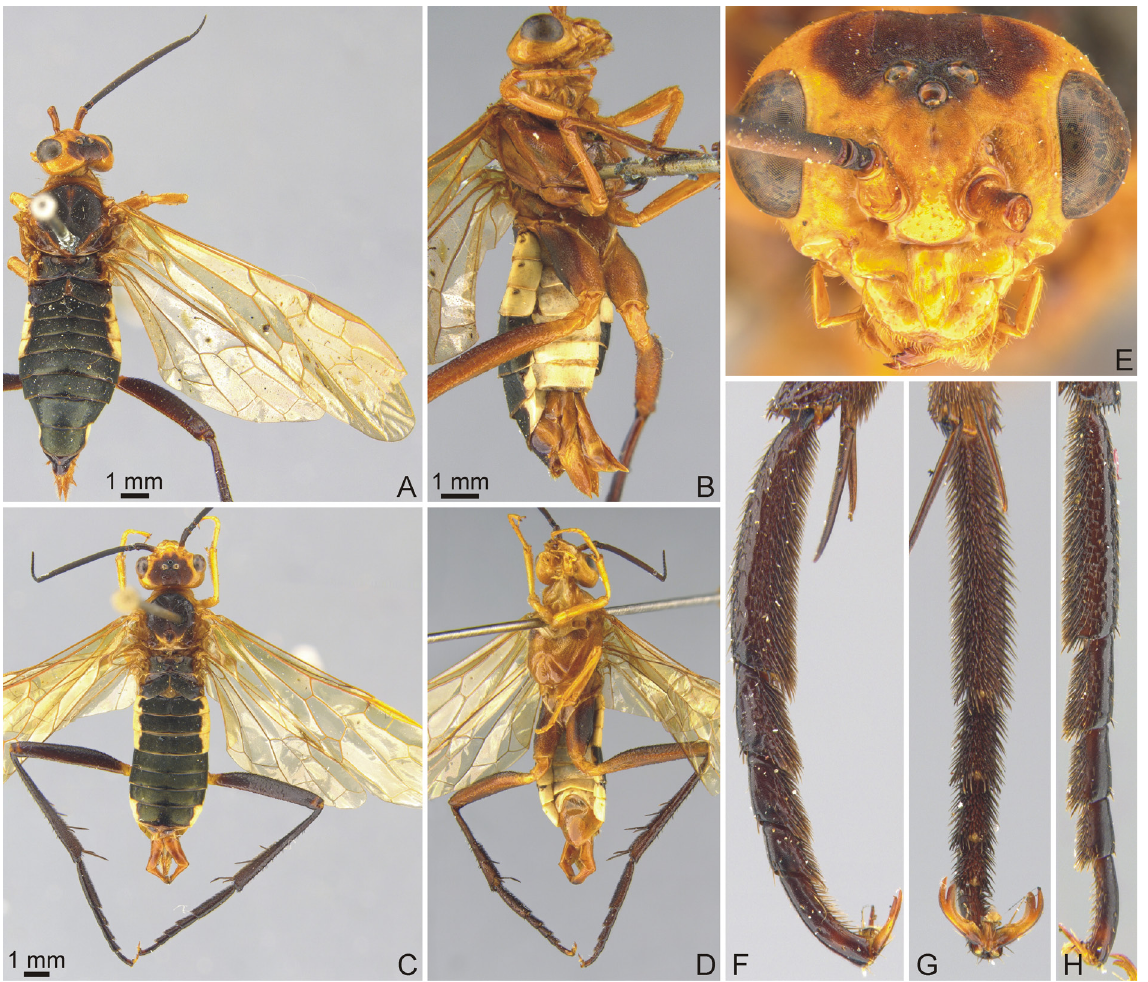
Fig. 5. Megaxyela gigantea Mocsáry, 1909. A–B . Habitus dorsal/lateroventral (♀, holotype of M. mikado , DEI-GISHym 22350, NSMT). C–D . Habitus dorsal/lateroventral (♂, 18507, NSMT). E . Head frontal (♀, holotype of M. mikado , 22350, NSMT). F–G . Metatarsus lateral/ventral (♀, holotype of M. mikado , 22350, NSMT). H . Metatarsus ventral (♂, 18507,